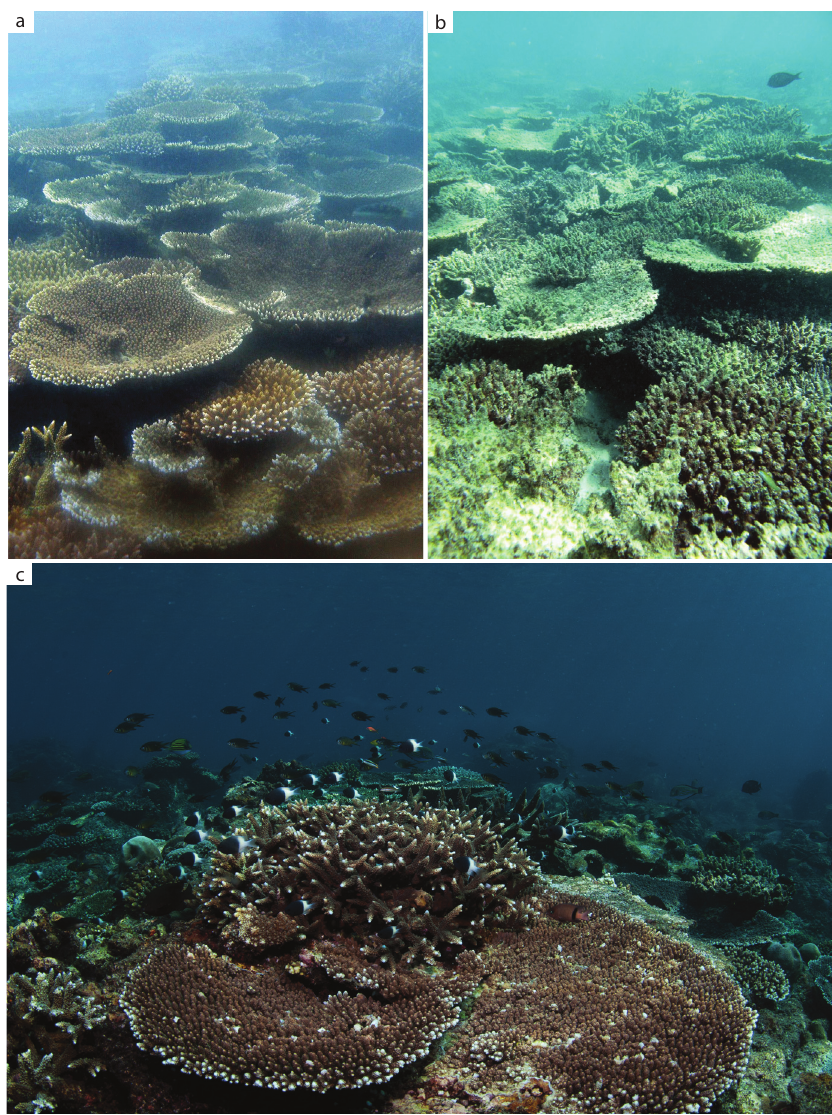
Figure 3. Acropora -dominated communities at Pulau Weh. ( a ) Reef crest at 2 m depth prior to bleaching (16 November 2009); ( b ) the same reef crest six weeks after the peak of bleaching (26 July 2010); ( c ) upper reef slope community at 6 m depth largely unaffected by the bleaching event, 25 February